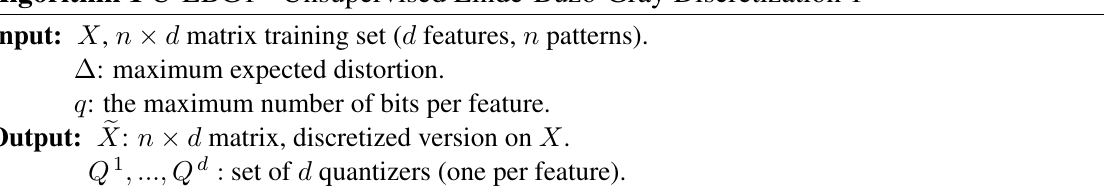
Algorithm 1 U-LBG1 - Unsupervised Linde-Buzo-Gray Discretization